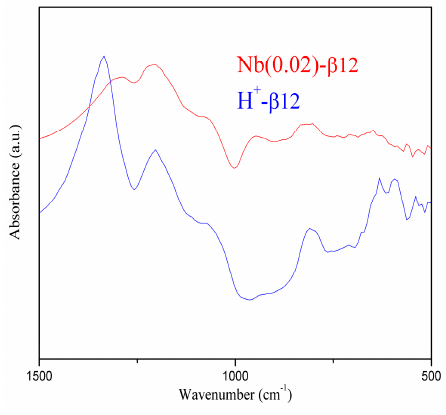
Figure 7. FTIR spectra of H- β 12 and Nb(0.02)- β 12.